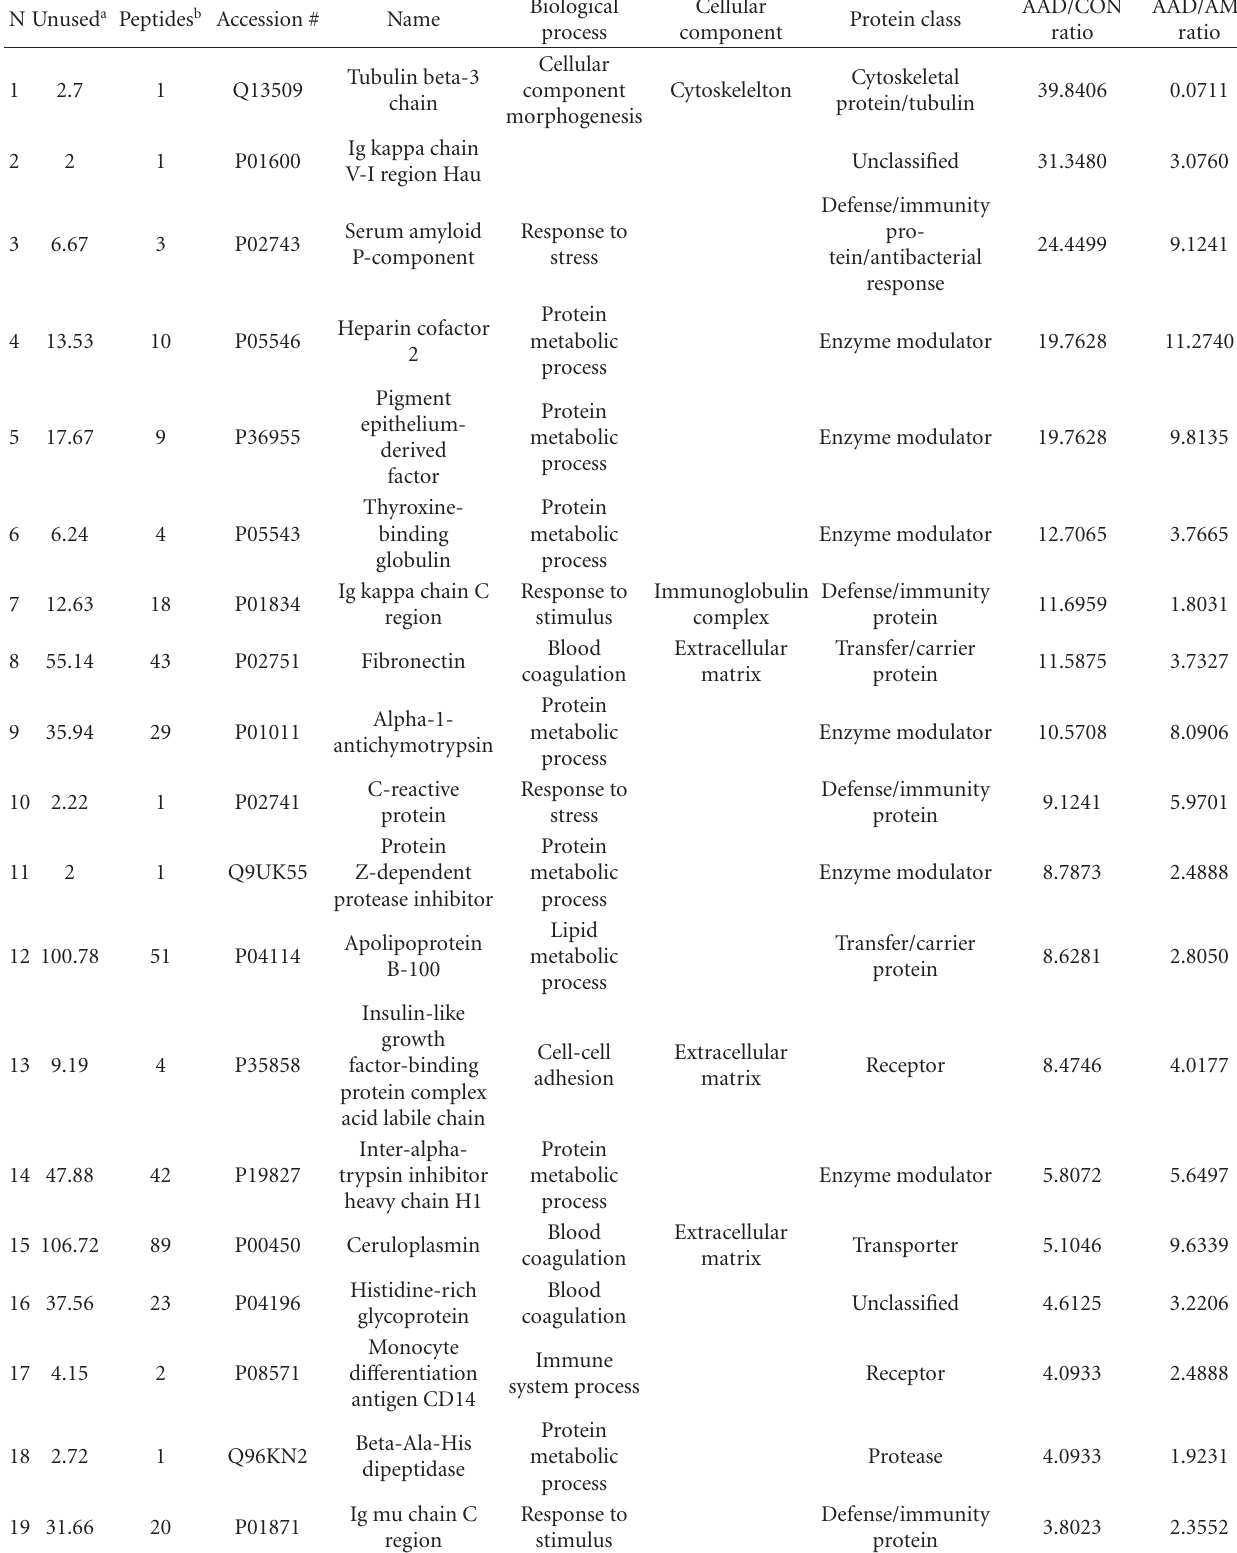
Table 2: List of the increased ( > 2-fold) protein targets identified and their corresponding class, associated biological process, and cellular